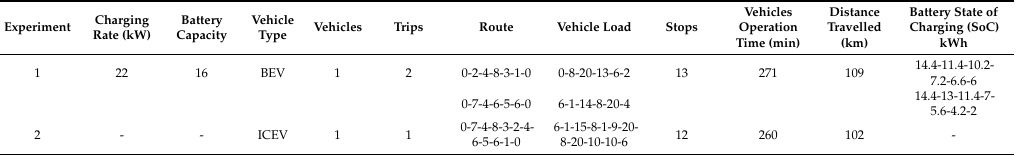
Table 5. Optimal solutions for electric and conventional